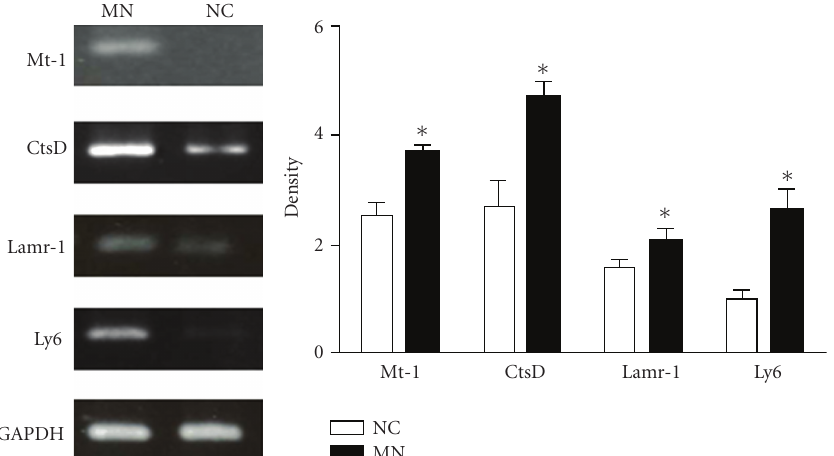
Figure 5: Confirmation of candidate protein expressions based on the microarray results by Western blot of kidney protein extraction. NC: normal control; MN: membranous nephropathy; Mt-1: metallothionein-1; CtsD: cathepsin D; Lamr-1: laminin receptor-1; Ly6e: lymphocyte antigen 6 complex ( n = 3). ∗ P < . 05.